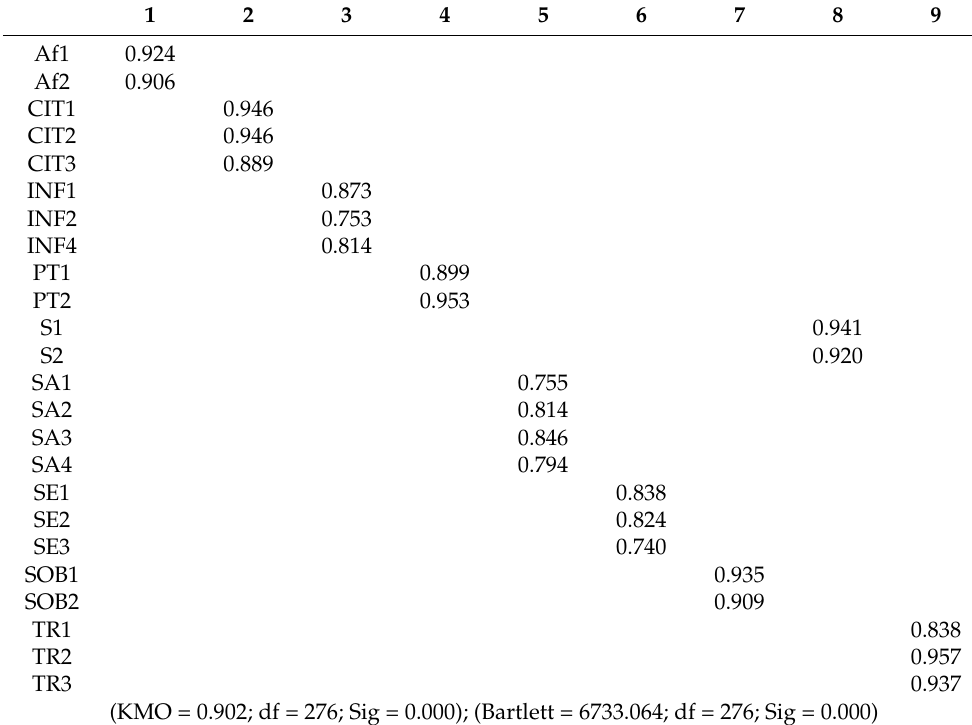
Table 2. Exploratory Factorial Analysis Loading Matrix.